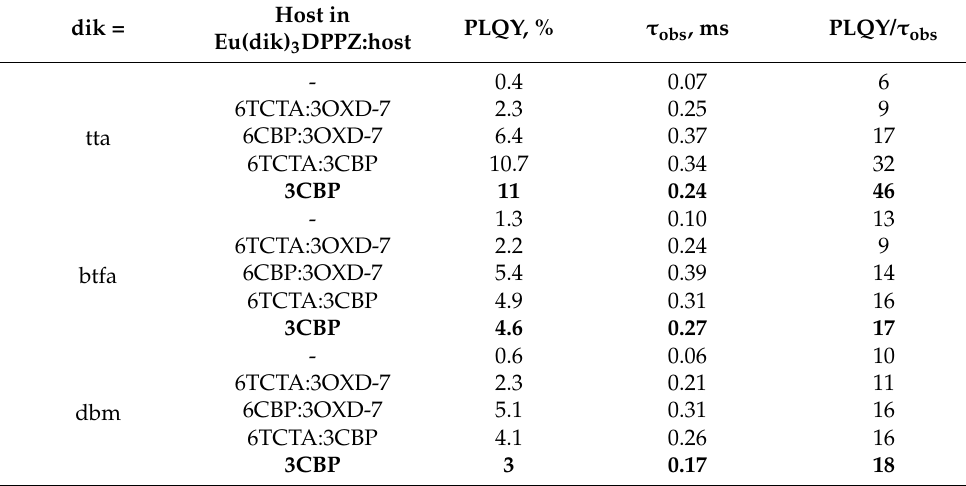
Table 1. Photoluminescent properties of the Eu(dik) 3 DPPZ:host films ( λ ex = 330 nm).